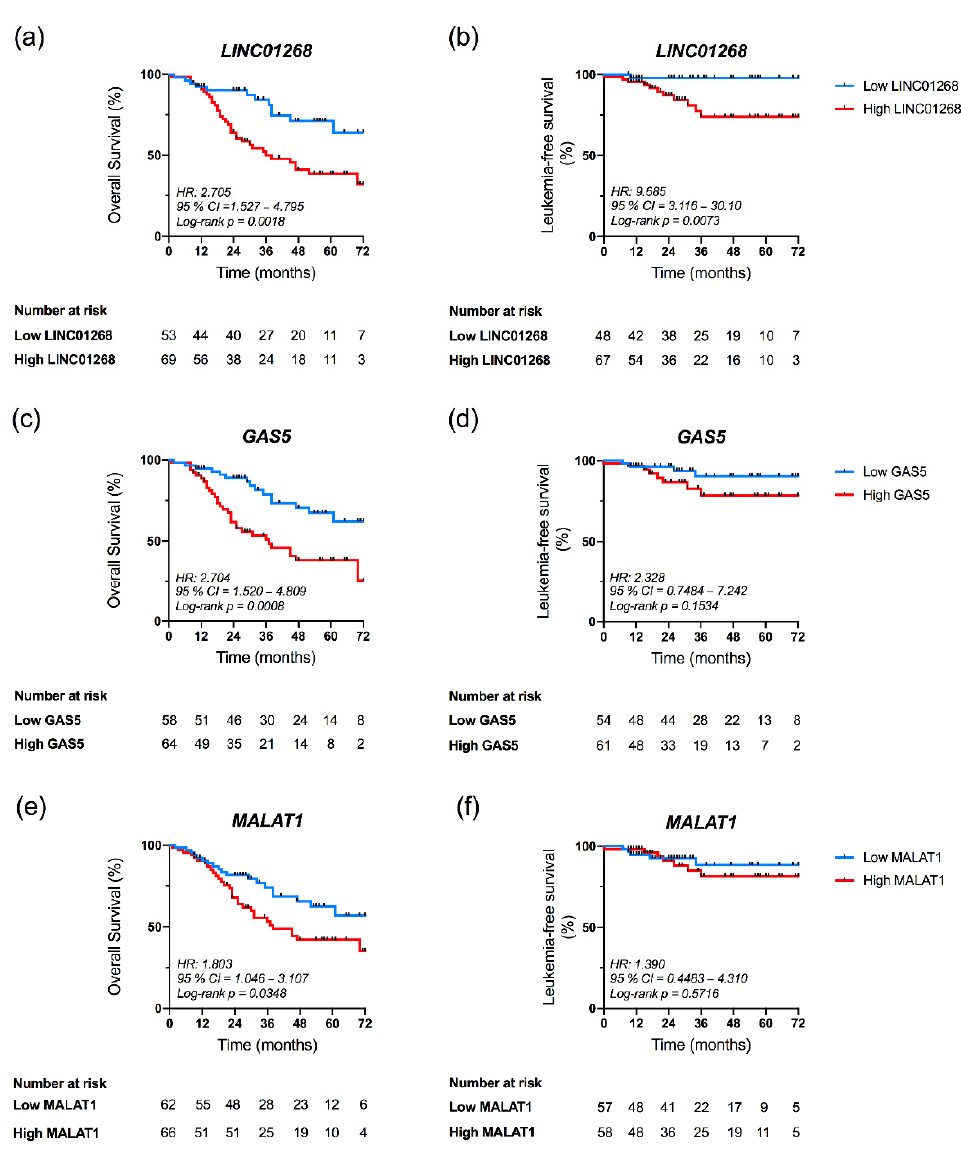
Figure 5. Kaplan–Meier analysis of Overall Survival (OS) and Leukemia-free Survival (LFS) according to LINC01268, GAS5 and MALAT1 plasma levels. Kaplan–Meier estimates of OS ( a , c , e ) and LFS ( b , d , f ) of MF patients in the study. Patients’ cohort was stratified into two groups (low and high) according to the plasma levels of target lncRNA, as described in the text. Differences between two survival curves was evaluated by Log-rank (Mantel–Cox) test. Blue and red curves represent patients with low or high levels of circulating target, respectively. HR = hazard ratio computed to determine the magnitude of differences between two curves; p -value was computed by log-rank test; 95% CI = 95% confidence interval.